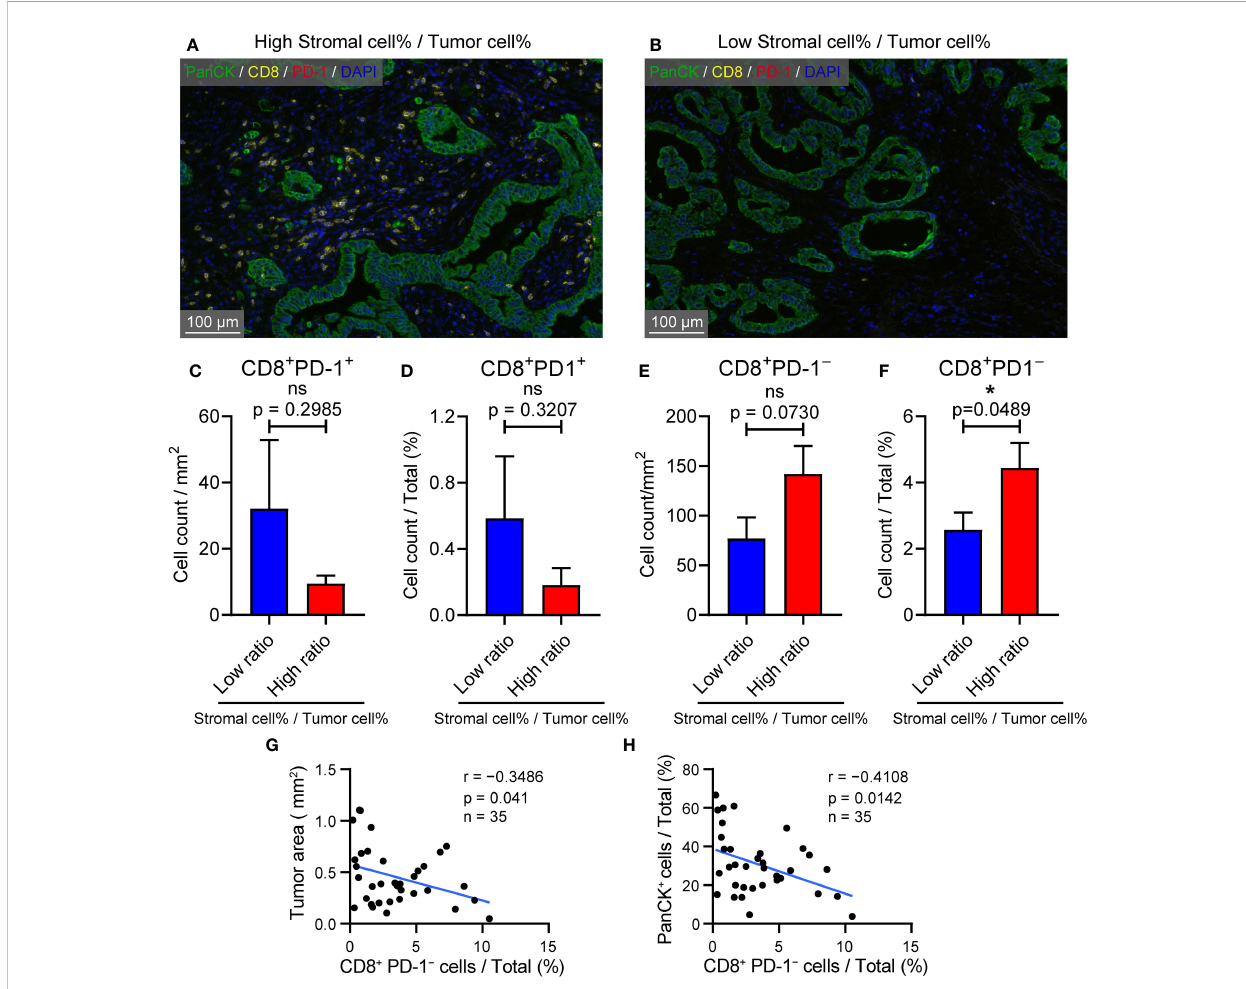
FIGURE 6 TME with high stromal and low tumor compartments is in favor of CD8 + PD-1 - T cell in fi ltration in PDAC. (A) Representative image of samples with abundant stromal cellular components and low tumor components. (B) Representative image of samples with low stromal cellular components and high tumor components. (C) Cell density of CD8 + PD-1 + T cells in samples with l low and high stromal cell %/tumor cell % ratio (D) CD8 + PD-1 + T cells % in samples with low and high stromal cell %/tumor cell % ratio. (E) Cell density of CD8 + PD-1 – T cells in samples with l low and high stromal cell %/tumor cell % ratio (F) CD8 + PD-1 – T cells % in samples with low and high stromal cell %/tumor cell % ratio. (G) Correlation between CD8 + PD-1 – T cells % and tumor area (mm 2 ). (H) Correlation between CD8 + PD-1 – T cells % and PanCK +